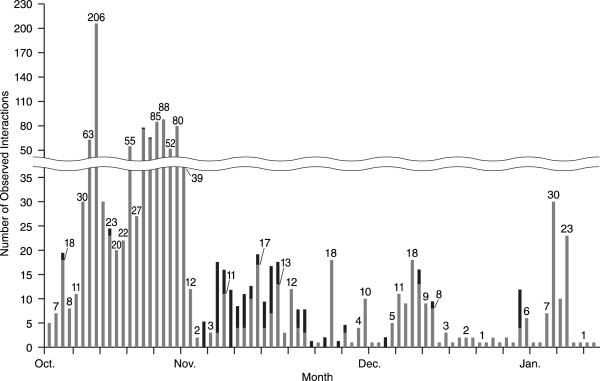
The number of daily animal interactions with PBRs observed between 10 Oct 2011 and 22 Jan 2012. Sea otter interactions shown in black and bird interactions in grey. The total number of interactions for each day is shown at the top of each bar.